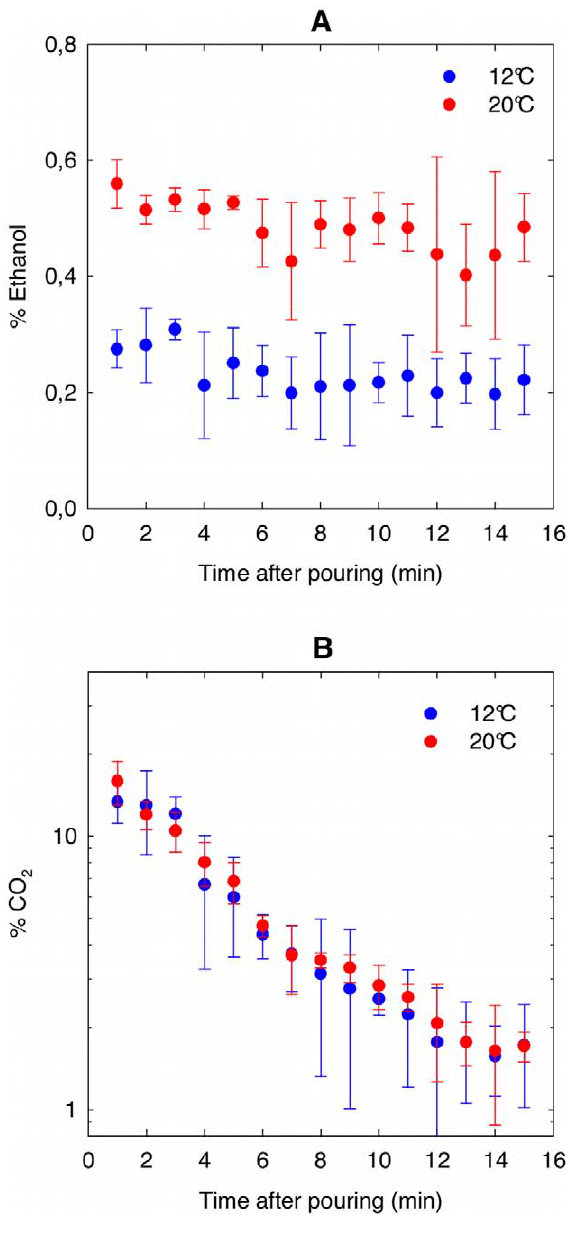
Figure 9. Monitoring ethanol and CO 2 above a flute poured with champagne served at 20 or 12 6 C. Ethanol (A) and CO 2 (B) concentrations found in the headspace above the champagne surface, all along the first 15 min after pouring champagne, depending on whether champagne is served at 20 u C or at 12 u C; each datum of each time series is the arithmetic average of six successive values recorded from six successive pouring; standard deviations correspond to the root-mean-square deviations of the values provided by the six successive data recordings.